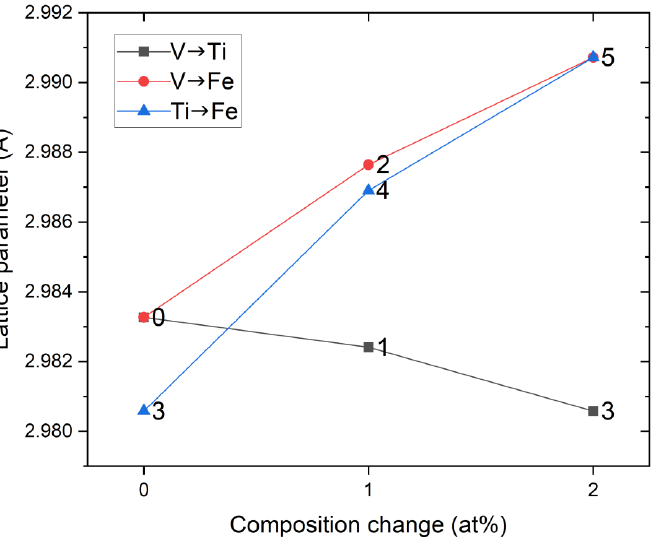
Figure 3. Lattice parameter change with composition for the series of the samples, 0 → 1 → 3, 0 → 2 → 5, and 3 → 4 → 5. Sample IDs are annotated. In the legend, V → Ti denotes that V replaces Ti and likewise for the other cases.